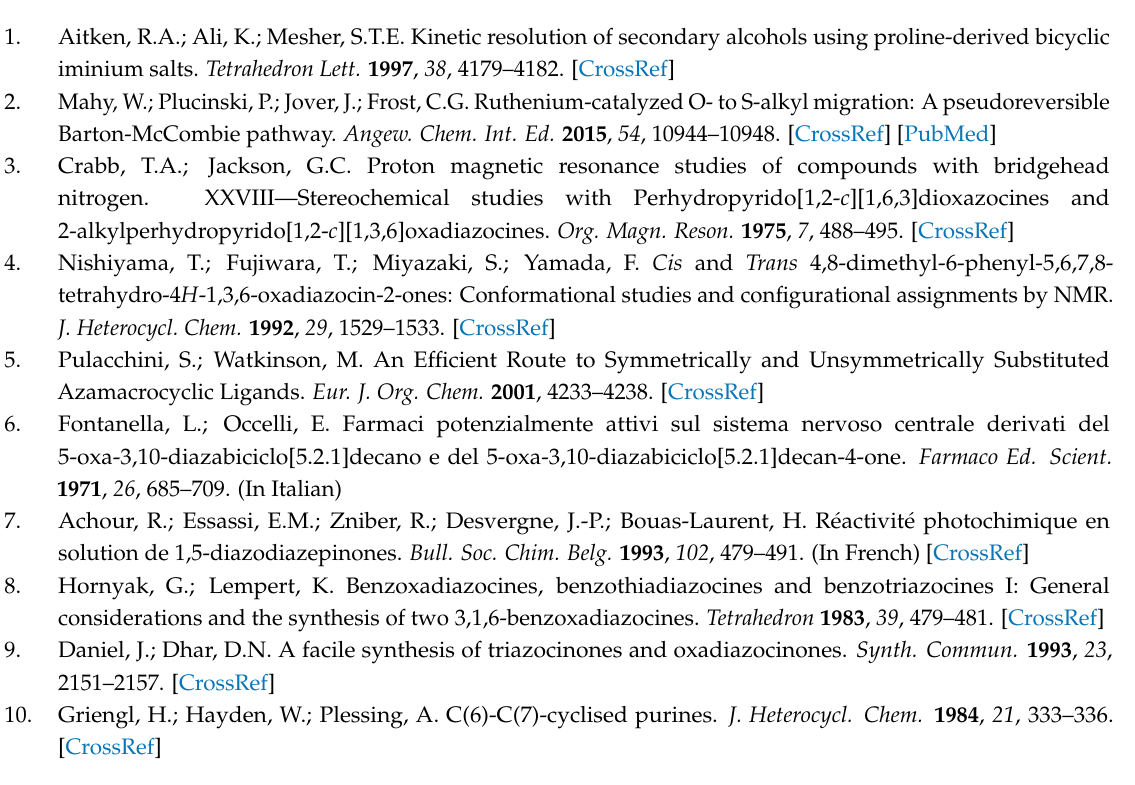
s1, Figure S1: 300 MHz 1 H-NMR spectrum of 2 in CDCl 3 , Figure S2: 75 MHz normal and DEPT 13 C-NMR spectra of 2 in CDCl 3 , Figure S3: COSY 2D H-H correlation NMR spectrum of 2 , Figure S4: HSQC 2D C-H correlation NMR spectrum of 2 , Figure S5: Mass spectrum for 2